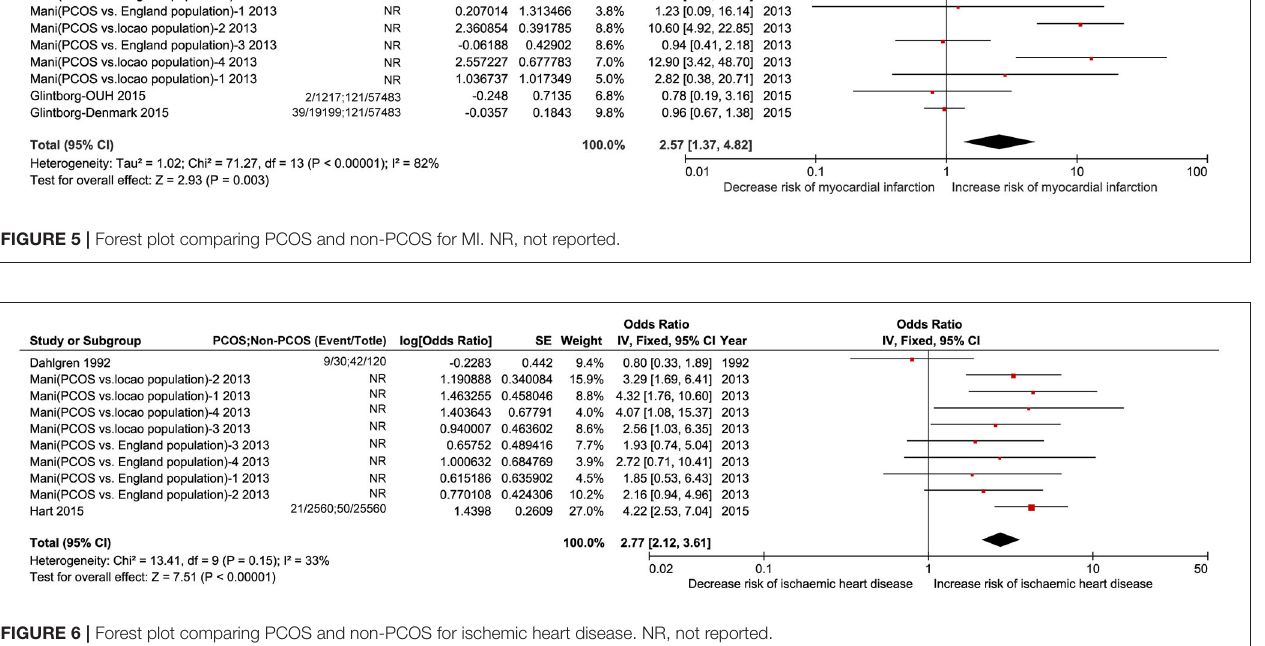
FIGURE 6 | Forest plot comparing PCOS and non-PCOS for ischemic heart disease. NR, not reported.